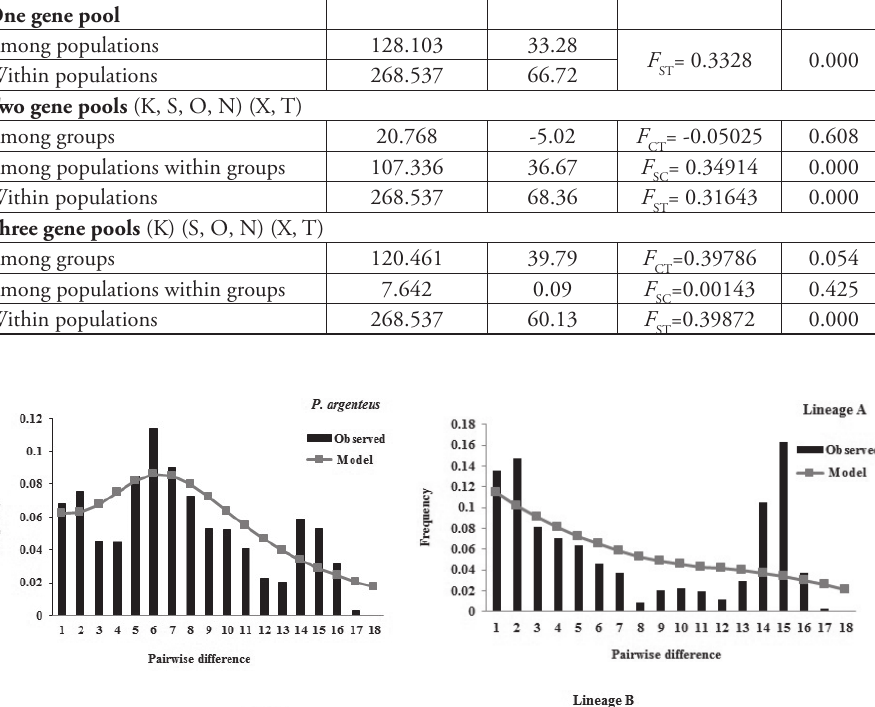
/ θ ), which esti- 1 0